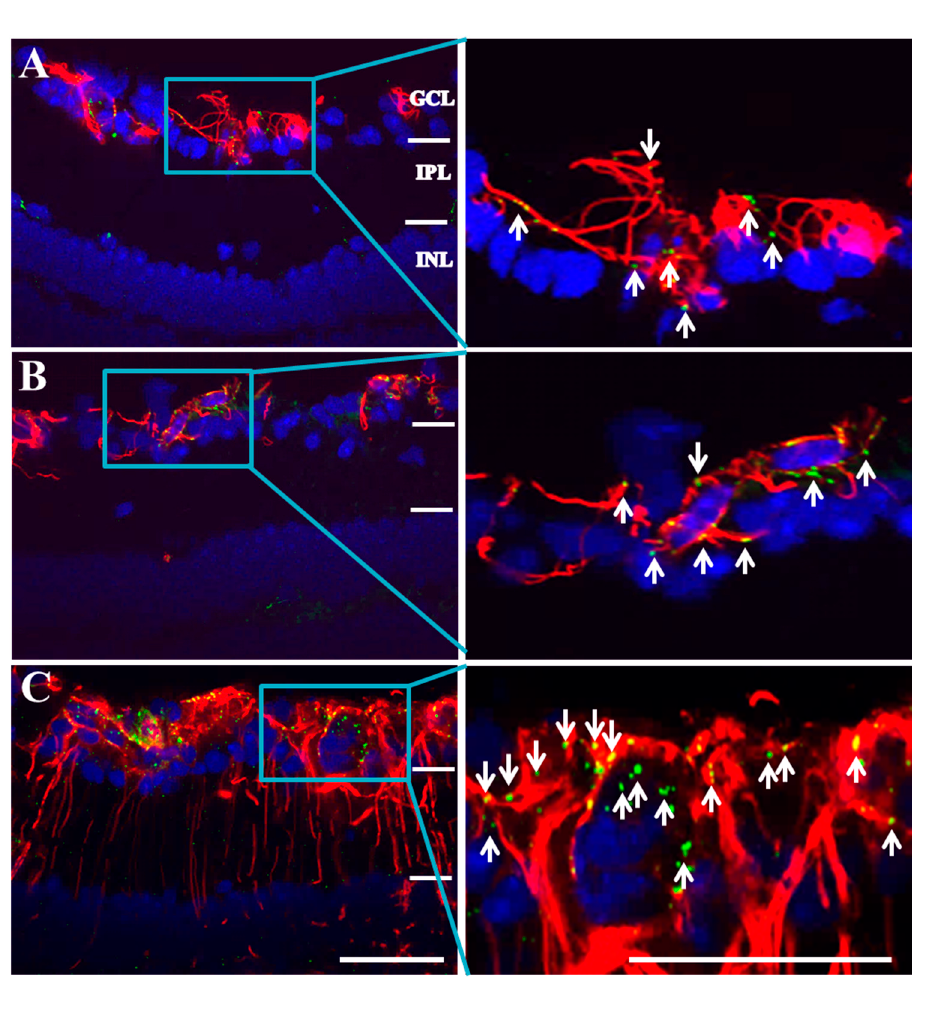
Figure 2. Connexin43 and glial fibrillary acidic protein (GFAP) expression in retinas of ( A ) wild-type; ( B ) Akita; and ( C ) Akimba mice. Connexin43 spots (green) were present in the GCL and co-localized with GFAP (red) in all mouse strains. GFAP labeling was evident within the GCL only in wild-type and Akita but spanned all retinal layers in Akimba mice. GFAP = glial fibrillary acidic protein; White arrows highlight connexin43 spots. GCL = ganglion cell layer; IPL = inner plexiform layer; INL = inner nuclear layer. Scale bar: 50 µm; n = 4 animals/group.